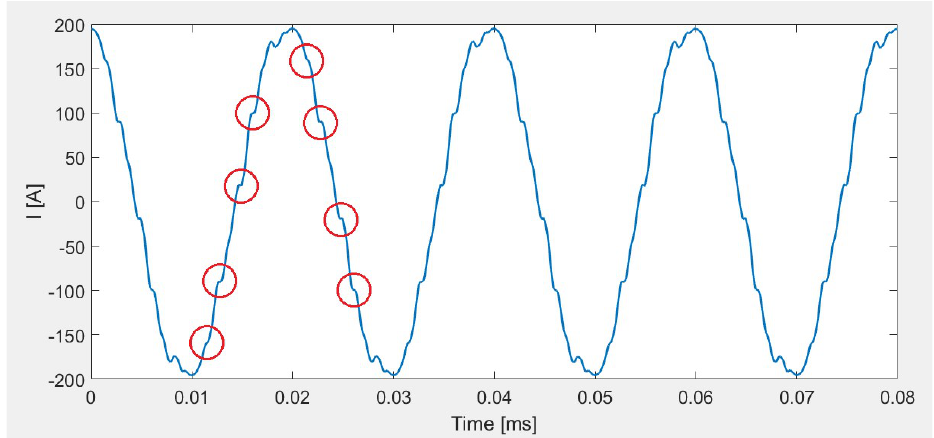
Figure 2. The actual L1 phase charger input current registered while charging the electric vehicle.